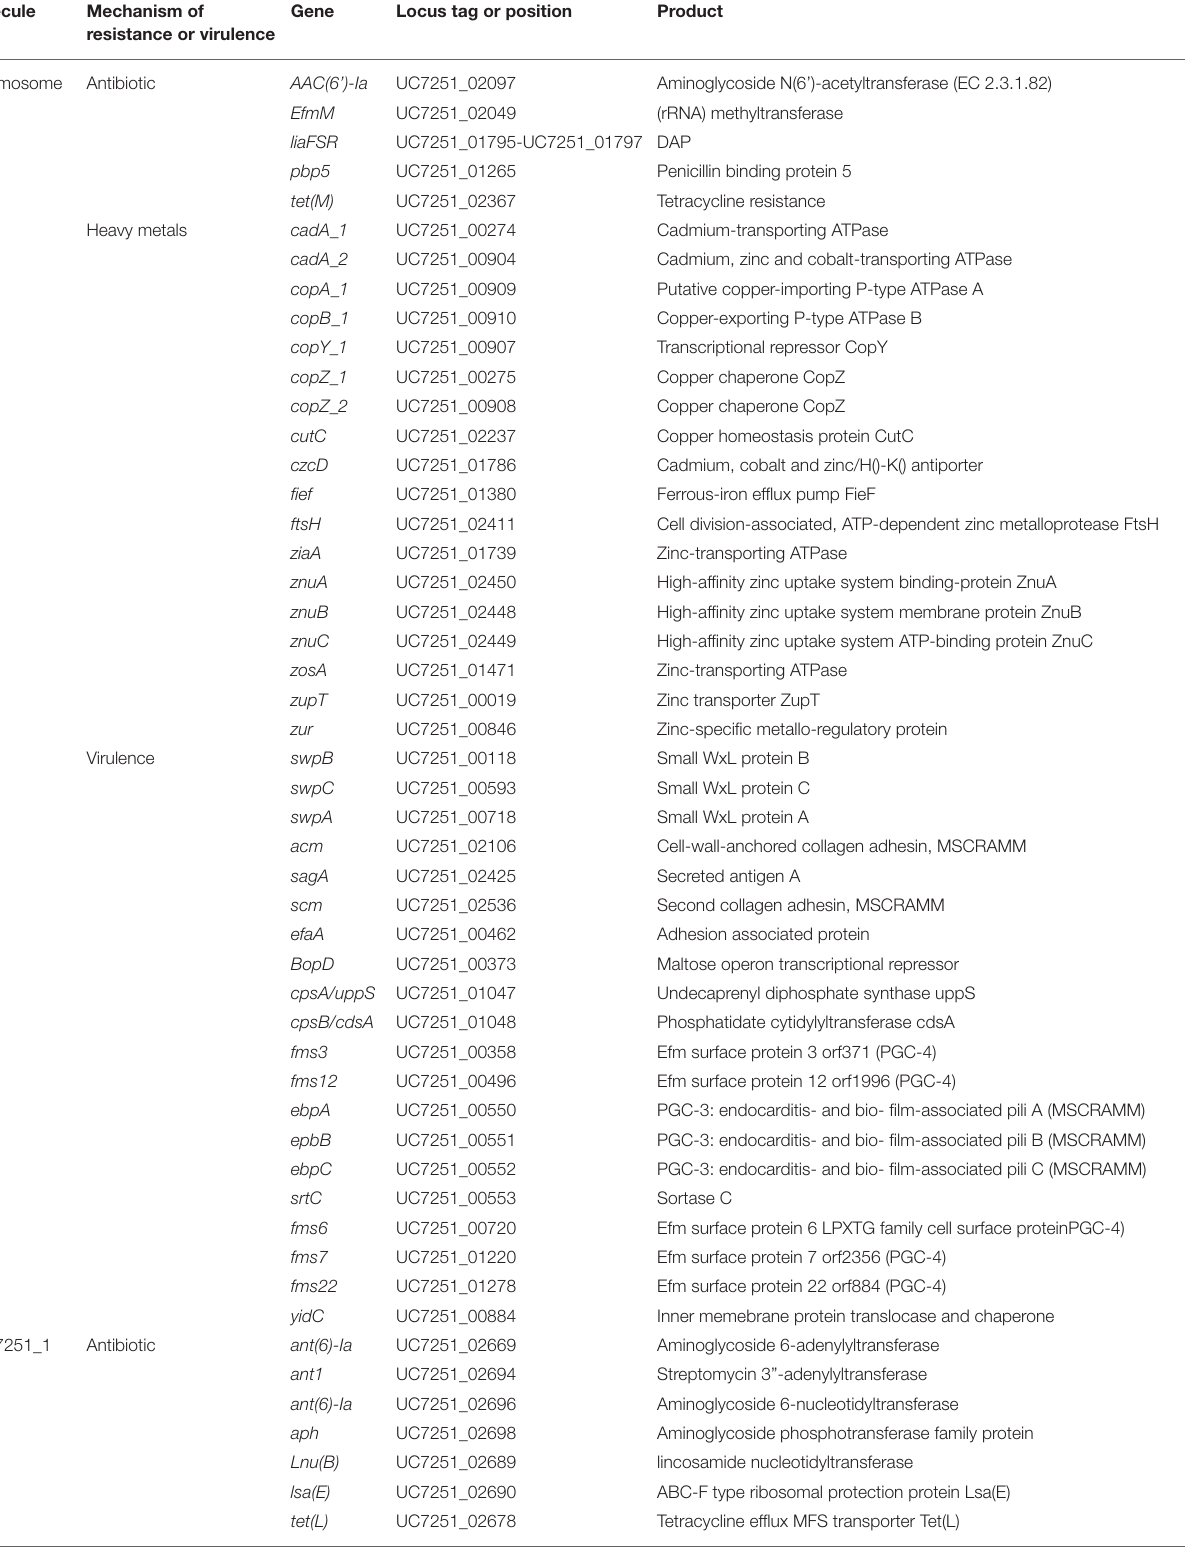
TABLE 3 | Distribution of virulence factors and AMR genes including antibiotic and heavy metal resistance genes in UC7251. Molecule Mechanism of resistance or virulence